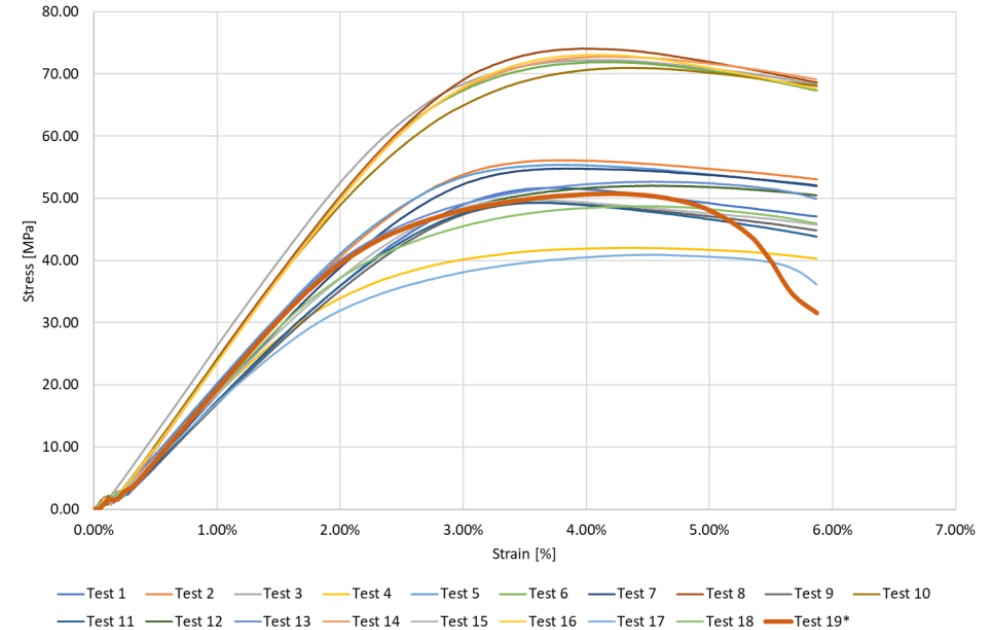
Figure 8. Stress-strain for flexural strength.